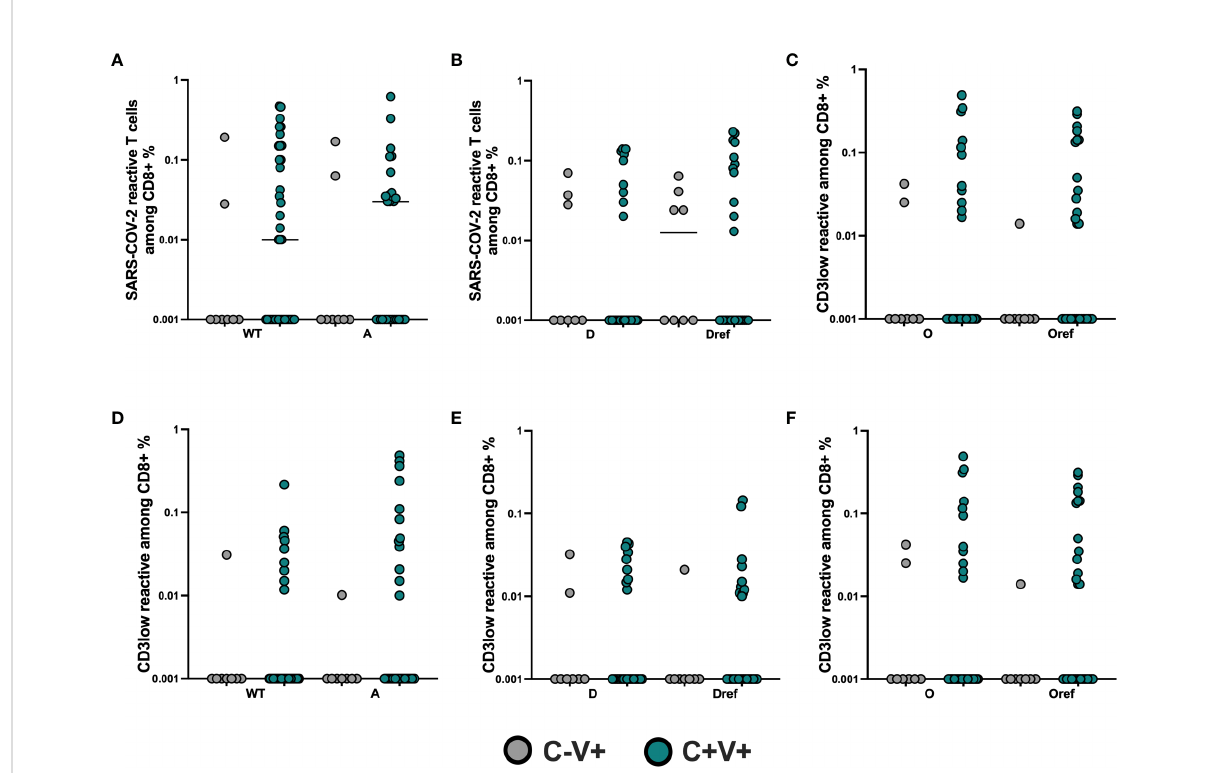
FIGURE 3 Comparable magnitude of SARS-CoV-2 CD8+ T cell response in C+V+ and C-V+. Comparison of SARS-CoV-2 S-reactive T cells among C+V+ and C-V+ study subjects. (A) Frequencies of WT- and alpha-reactive CD8+ T cells. (B) Frequencies of delta- and Dref-reactive CD8+ T cells. (C) Avidity of SARS-CoV-2 reactive CD8+ T cells was approached by determining the CD3low+ cells among CD8+CD137+ cells. Frequencies of omicron- and Oref-reactive CD8+ T cells. (D) Frequencies of WT- and alpha-reactive CD8+CD3low+ T cells. (E) Frequencies of delta- and Dref-reactive CD8+CD3low+ T cells. (F) Frequencies of omicron- and Oref-reactive CD8+CD3low+ T cells. Antigen-reactive responses were considered positive after the non-reactive background was subtracted, and more than 0.01% were detectable. Scatterplots show line at median. Unpaired data were compared with Mann-Whitney-test. P<0.05 was considered signi fi cant, only signi fi cant p values are documented in the fi